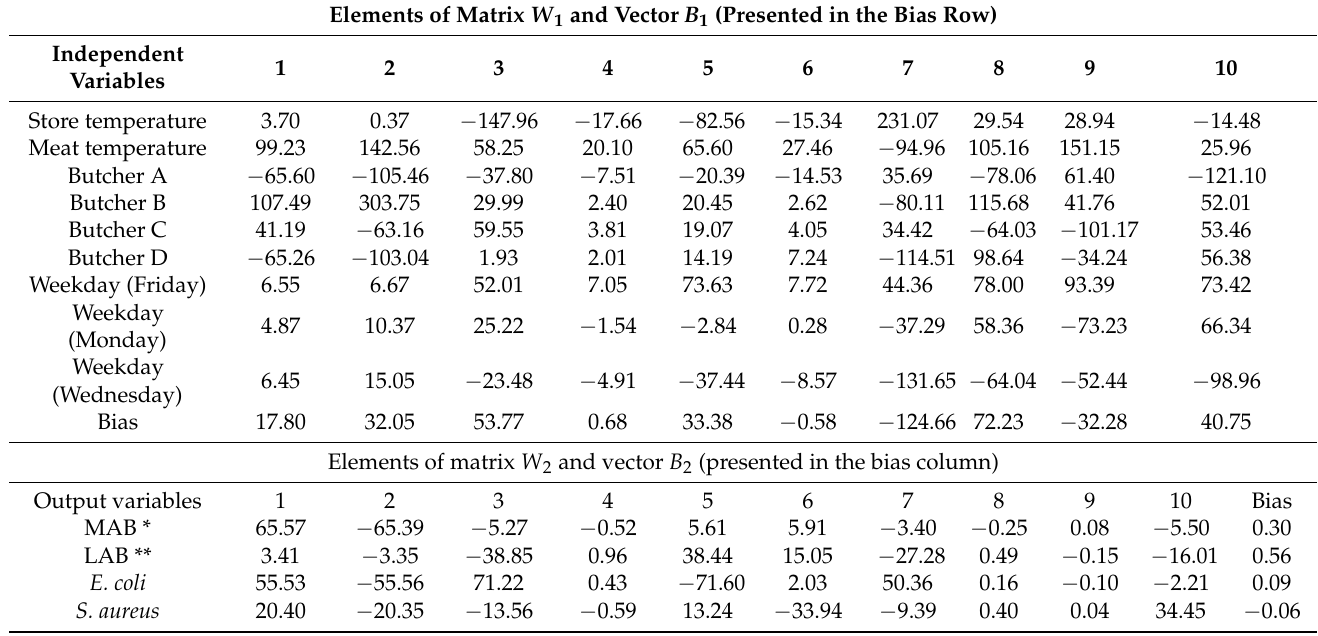
Table 4. Coefficients assigned to the hidden and the output layers (weights and biases).